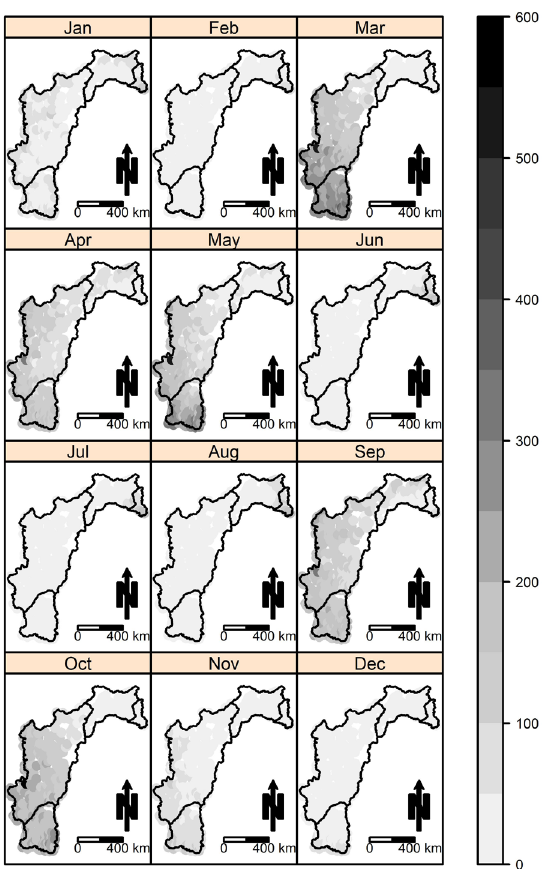
Figure 4. Map of the median value of precipitation in the SFRB for the 1989–2019 period.